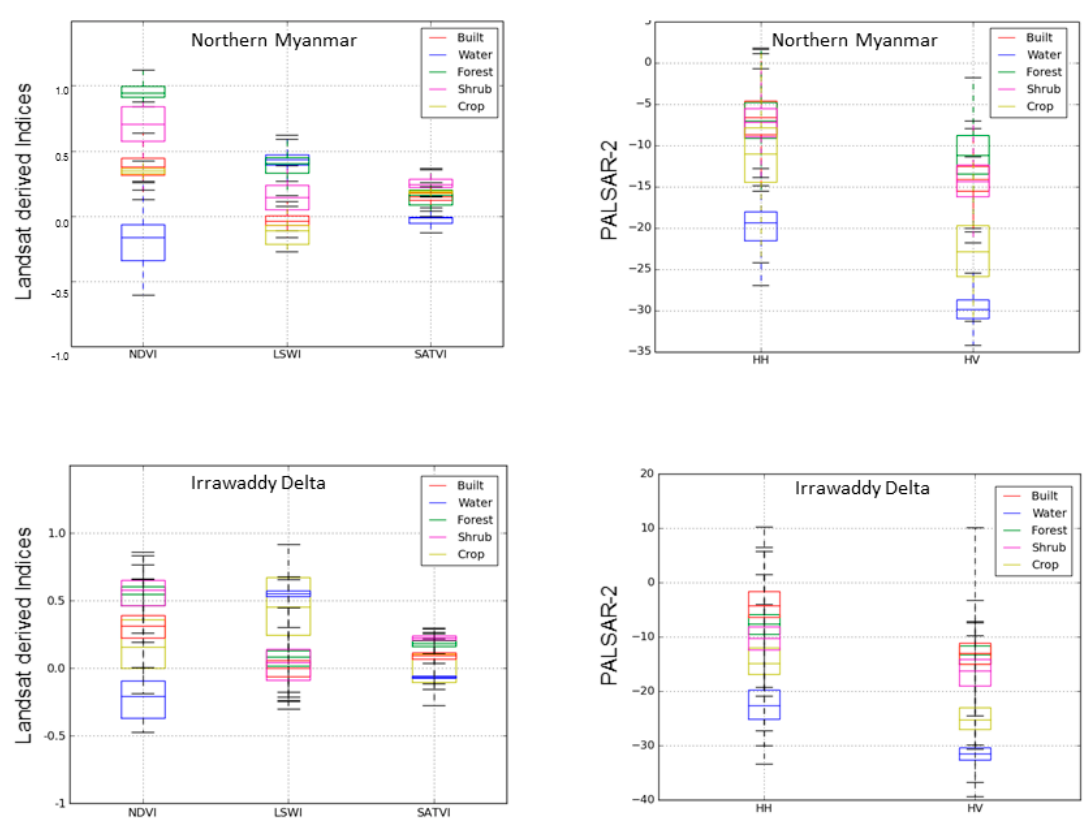
Figure 8. Landsat-8 indices (NDVI, LSWI, SATVI) and PALSAR-2 (HH, HV) backscatter responses for two selected training regions showing overlap and/or separation between the two regions among the remote sensing observations.